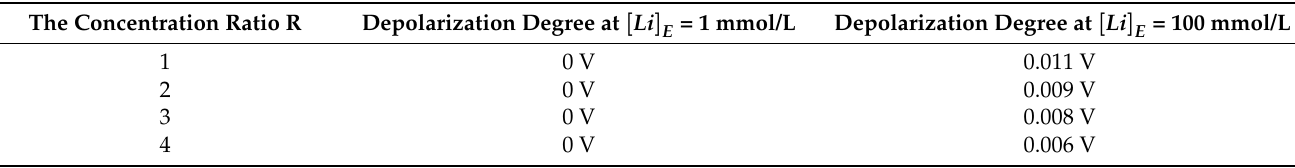
Based on Table 24, a numerical description of the depolarization degrees can be obtained. See Table 25. Table 25. The table shows the depolarization degree based on the classical transport of Li-6 as in graph (b) of Figure 9. The Concentration Ratio